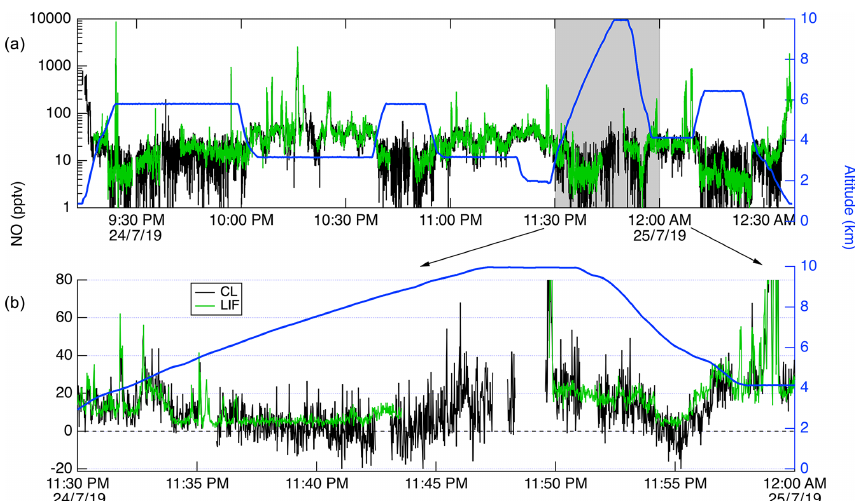
Figure 13. Time series of CL (black) and LIF (green) data from a DC-8 flight on 24 July 2019. (a) shows all of the flight, with the altitude of the DC-8 plotted on the right axis in blue. (b) shows a 20min segment expanded.